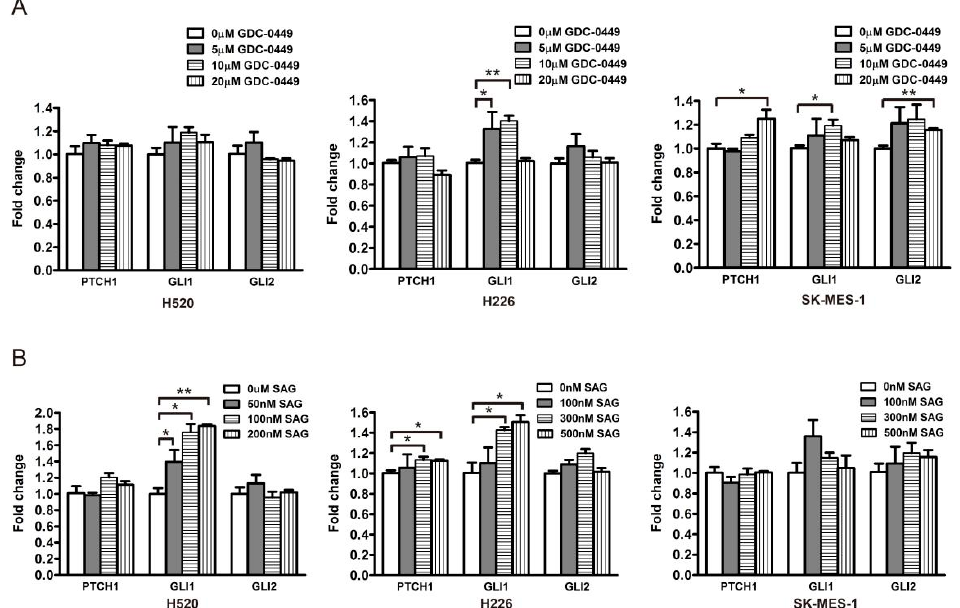
Figure 5. SMO does not modulate the expression of GLI target genes in LSCC cells. GDC-0449 is an SMO antagonist and SAG is an SMO agonist. ( A ) The expression of the Hh pathway components (PTCH1, GLI1, and GLI2) in LSCC cells (H520, H226, and SK-MES-1) treated with GDC-0449 was measured by quantitative RT-PCR. ( B ) The expression of the Hh pathway components (PTCH1, GLI1, and GLI2) in LSCC cells (H520, H226, and SK-MES-1) treated with SAG was measured using quantitative RT-PCR. GAPDH served as the loading control. Data are shown as the mean ± SD (two-sided independent Student’s t -test, * p < 0.05 and ** p < 0.01).